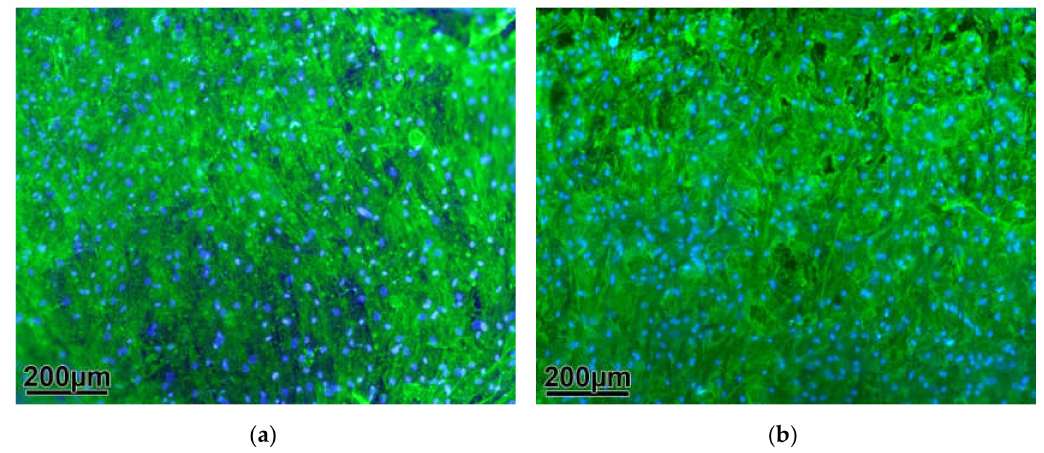
Figure 2. Immunofluorescence microscopic (IF): numerous cells attached to the coated ( a ) and uncoated ( b ) grid surface are visible due to actin immunofluorescence